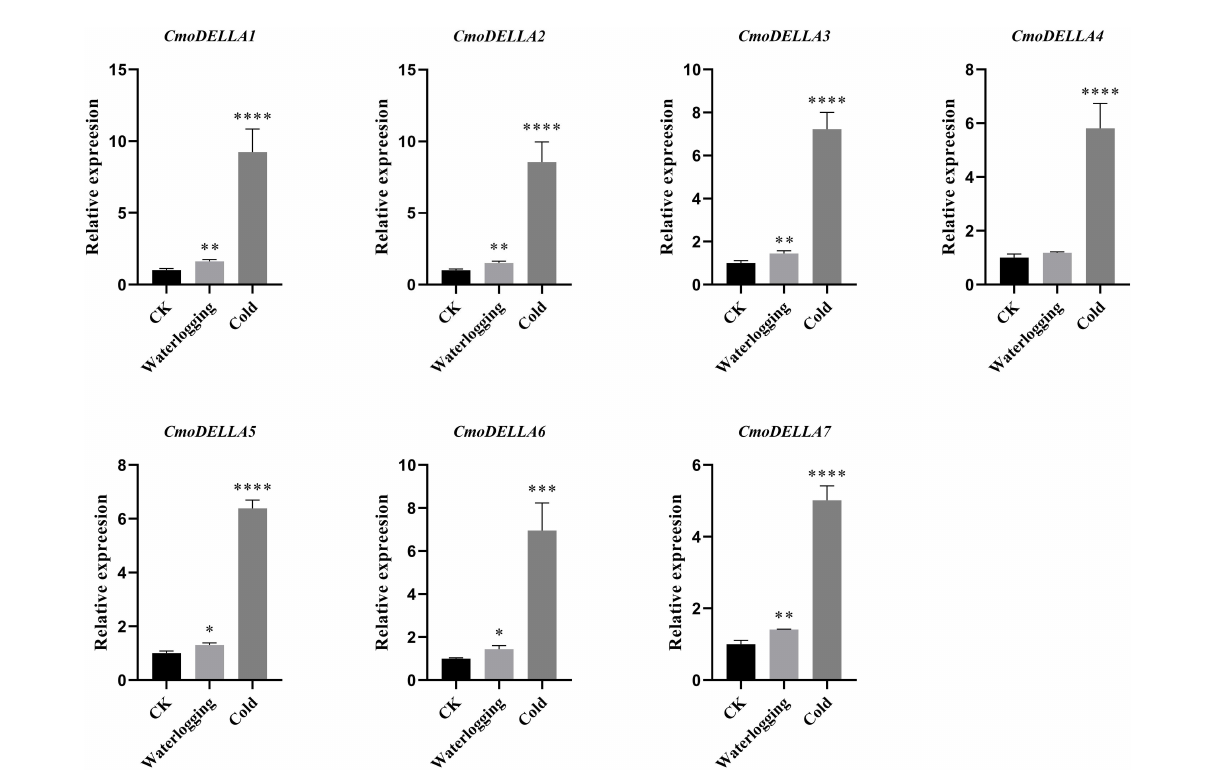
FIGURE 9 Expression levels of CmoDELLA genes in response to waterlogging stress and cold stress after 10 days. The relative expression levels of CmoDELLA genes are normalized with respect to the reference gene ( CmoActin ). The X-axis represents the waterlogging stress and cold stress. The Y-axis represents the relative expression levels. The values are denoted as the means ± SDs. The signi fi cant difference is represented by asterisks at * P < 0.05, ** P < 0.01, *** P < 0.001 and **** P <